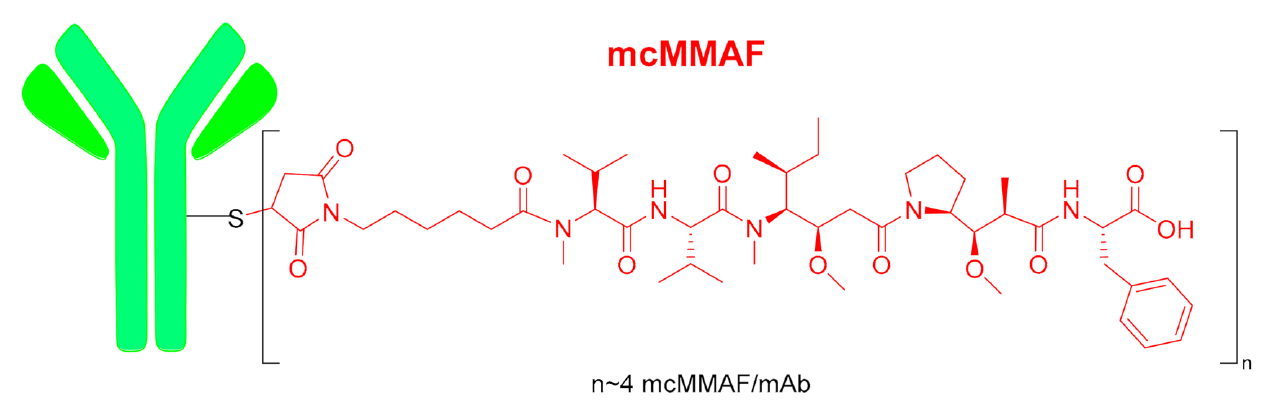
Figure 2. Structure of belantamab mafodotin-blm.